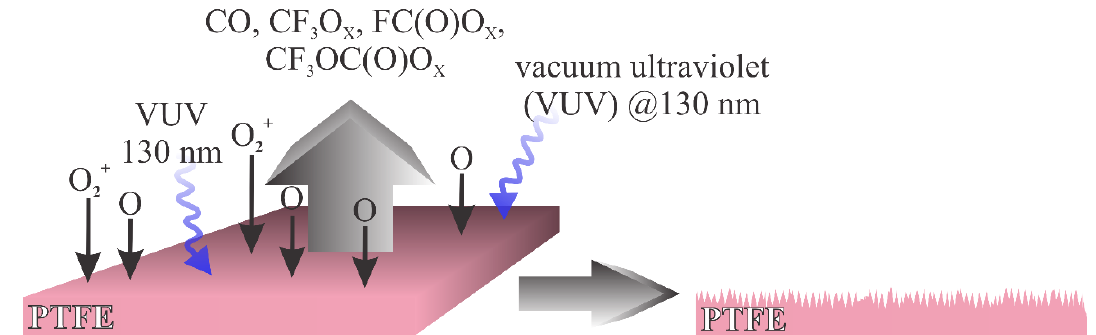
Figure 7. Schematic of the interaction between oxygen plasma and PTFE.